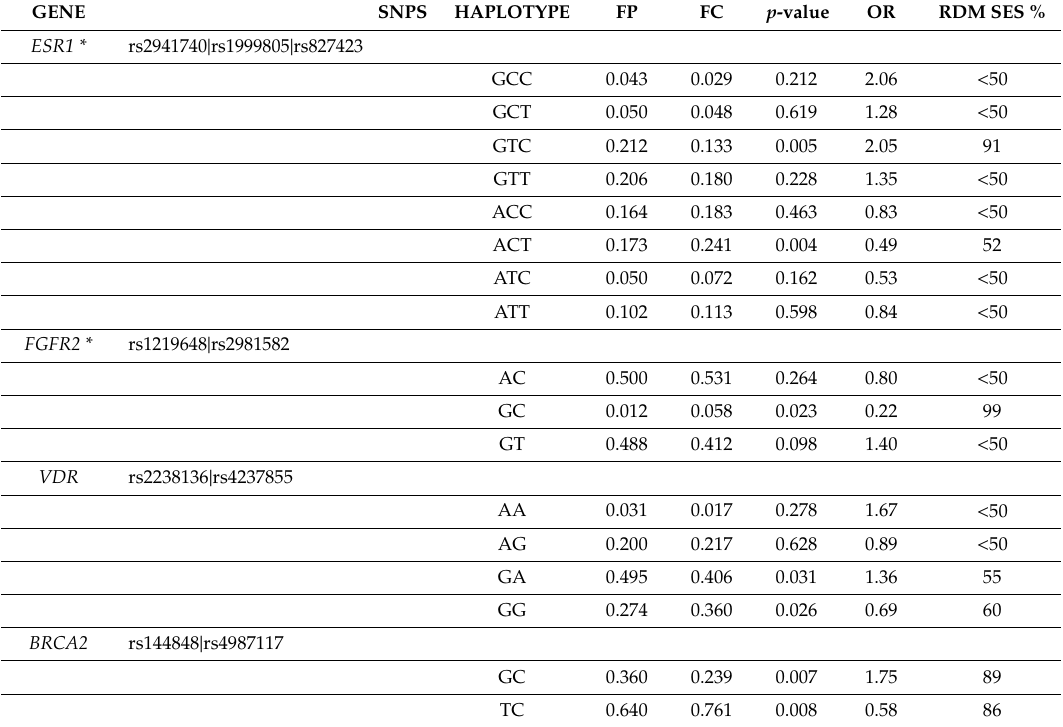
Table 2. Haplotype association analysis of ESR1, FGFR2, VDR, BRCA2 genes for the complete sample and randomized